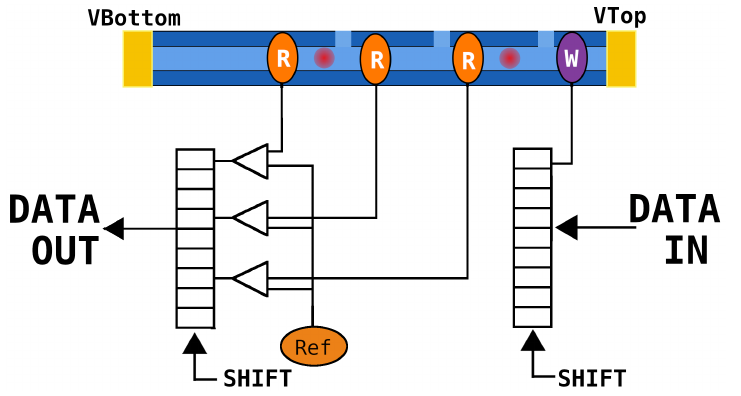
Figure 5. Read and write mechanism. The track has more than one read head to reduce the read operation latency. In order to sense the skyrmion presence under the read-head, the value produced is compared with a